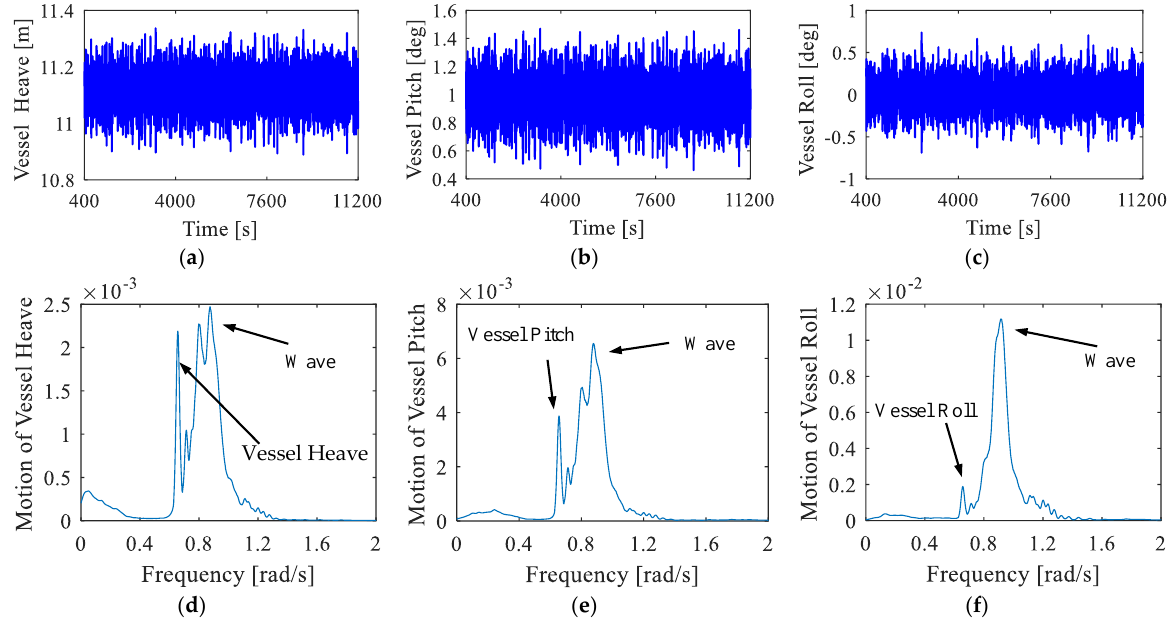
Figure 13. Response time series and PSD of vessel motion ( H s = 1.5 m, T p = 7 s, Dir = 45 deg, JL1-Z3). ( a ) Time series of vessel heave; ( b ) Time series of vessel pitch; ( c ) Time series of vessel roll; ( d ) PSD of vessel heave; ( e ) PSD of vessel pitch; ( f ) PSD of vessel roll.